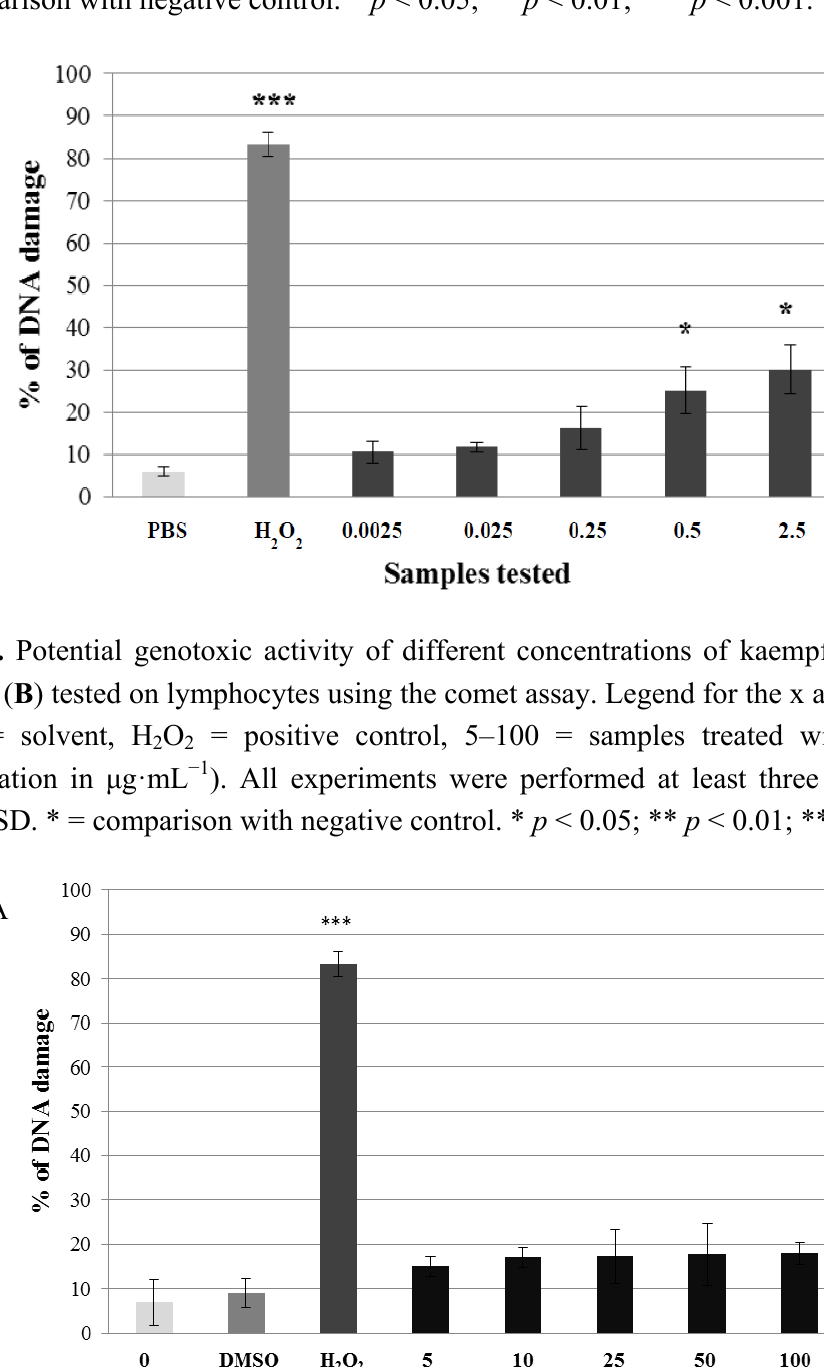
Figure 2. Potential genotoxic activity of different concentrations of A. rusticana extract (AE) tested on lymphocytes using the comet assay. Legend for the x axis: PBS = negative O = positive control, 0.0025–2.5 = samples treated with AE (concentration control, H 2 2 in mg·mL − 1 ). All experiments were performed at least three times. Mean values ± SD.